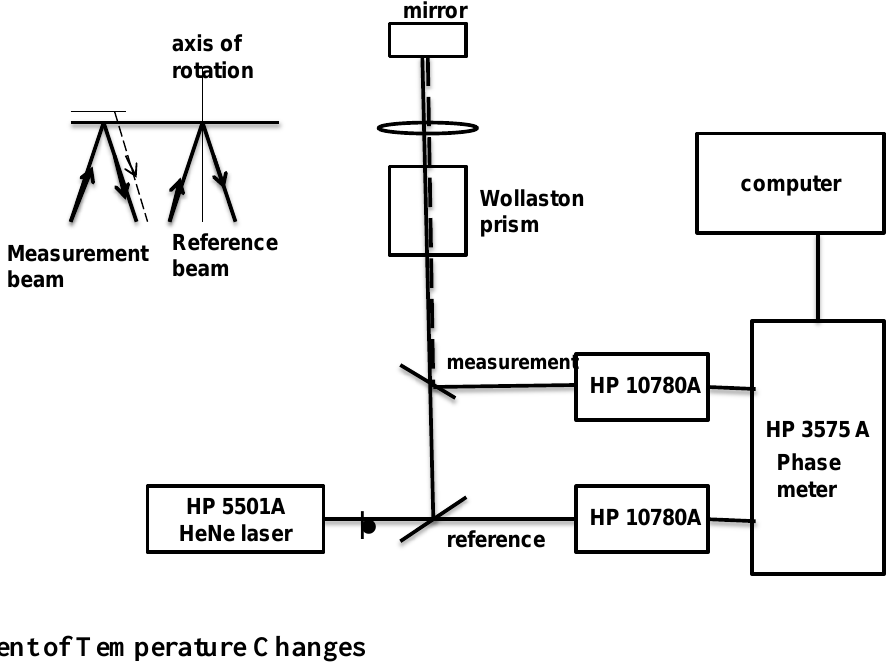
Figure 8. A block diagram of the optical heterodyne detection setup for surface roughness measurement. Inset shows the beam configuration on the mirror surface